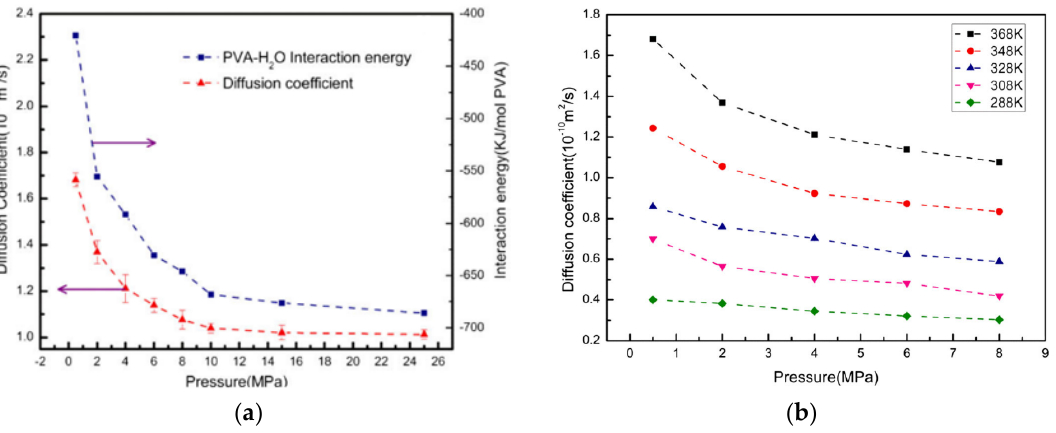
Figure 25. ( a ) Diffusion coefficients and the interaction energy of PVA–H 2 O versus pressures (T = 368 K); ( b ) diffusion coefficients of H 2 O versus pressure in PVA at different temperatures [90].